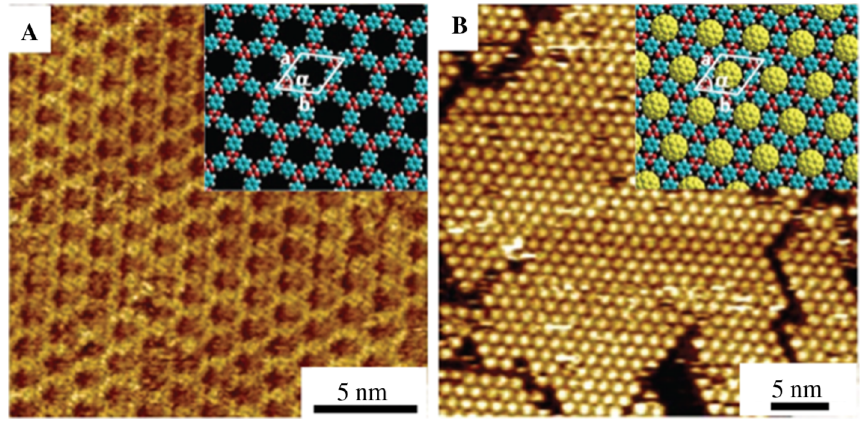
Figure 10: STM images of the COF-1 (A) and its host-guest co-assembly with C